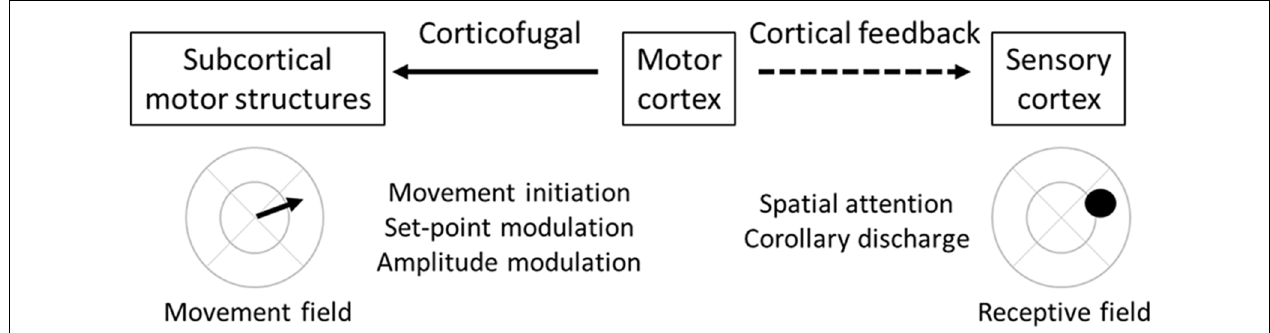
FIGURE 3 | Feedforward and feedback functions of motor cortex. Motor cortex (center) projects both to subcortical structures along corticofugal pathways (solid arrow) and to sensory cortices along cortical feedback pathways (dashed arrow). These two pathways originate from different populations of motor cortex pyramidal neurons. However, within local regions of the motor cortex, there is alignment between the target movement field of the corticofugal neurons and the target receptive field of the cortical feedback neurons. Functions of the corticofugal pathway relate to motor control, including movement initiation, set-point modulation, and amplitude modulation. Functions of the cortical feedback pathway relate to spatial attention and corollary